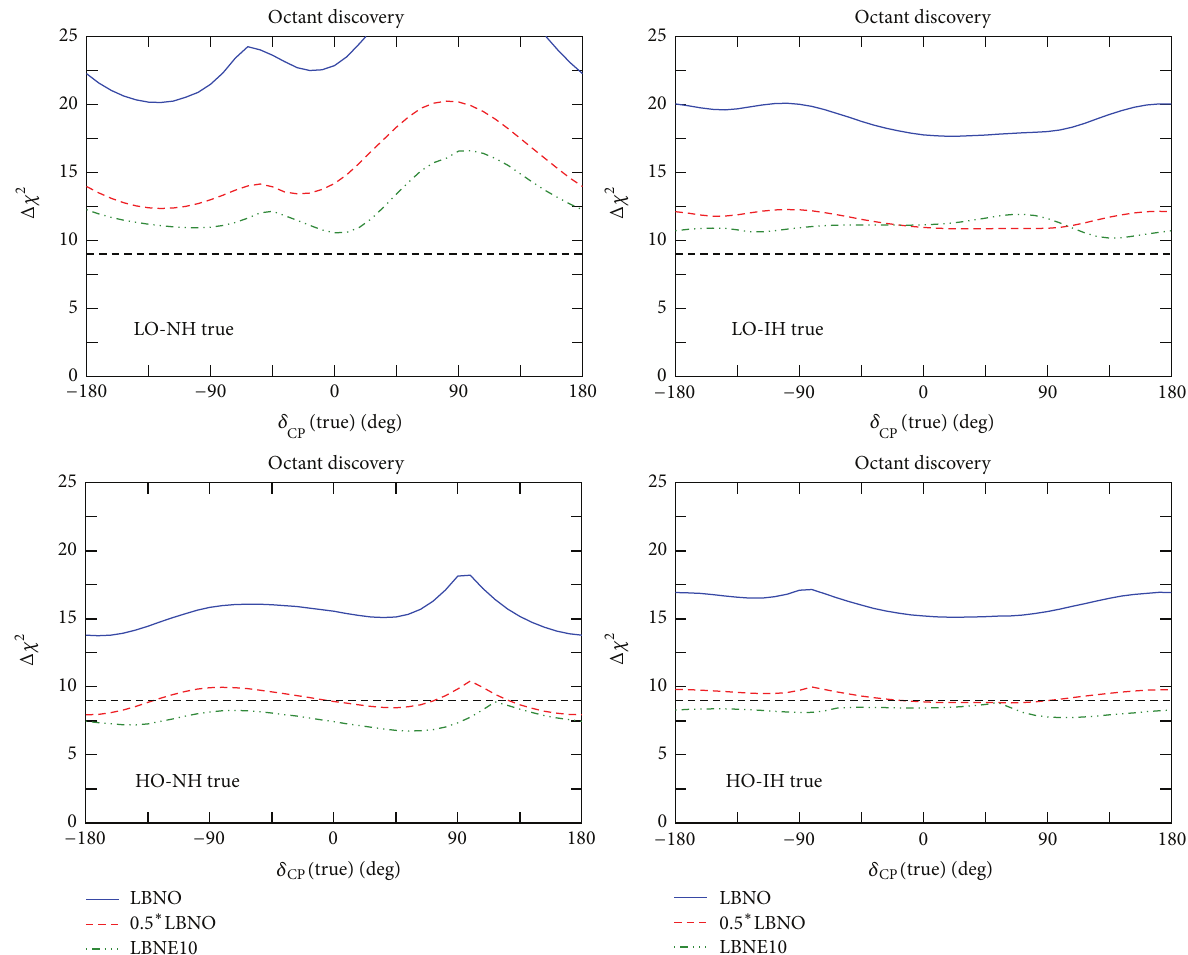
Figure 15: Octant resolving capability for LBNO, 0.5 ∗ LBNO, and LBNE10. Results are shown for the four possible true octant-hierarchy combinations.